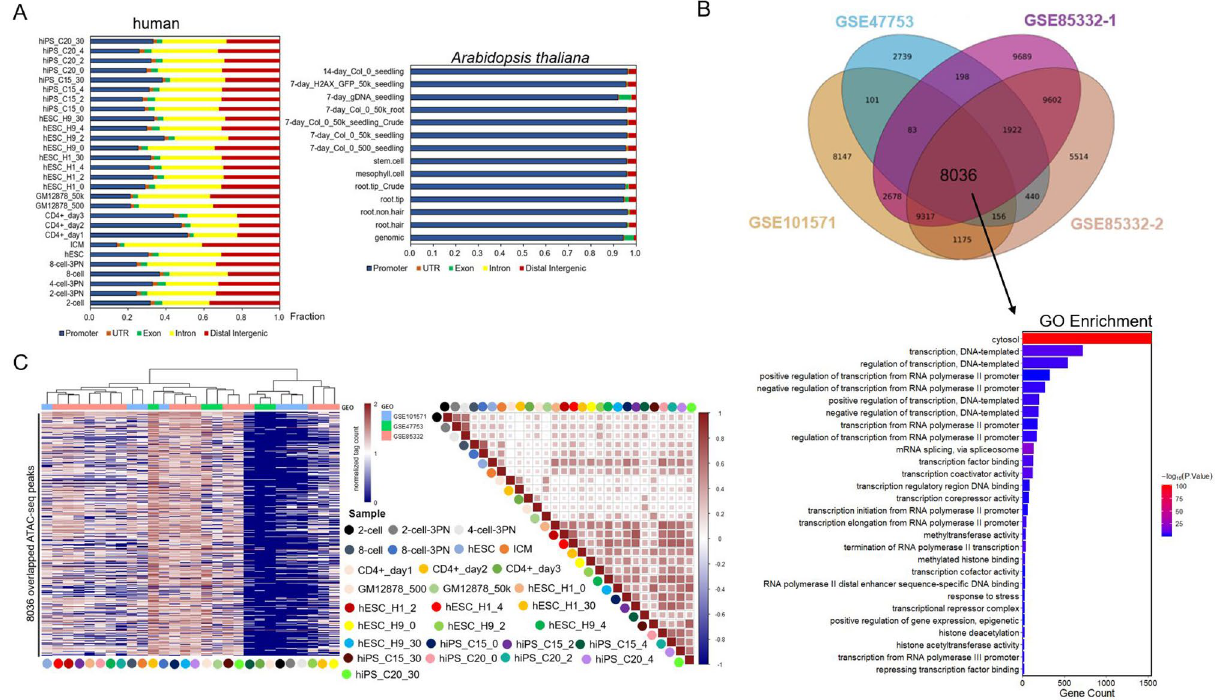
Figure 2. Genomic and functional annotation of accessible regions. ( A ) Genomic distributions of enriched accessible regions identified in ATAC-seq samples. THS peaks within TSS ± 3 kb are considered as promoter THS, and those not located in promoters, exons, introns, or UTRs are labeled as distal intergenic. ( B ) GO functional enrichment analysis of overlapped peaks. Upper part integrates Upset and Venn method to identify overlapping peaks across all human samples. Bottom part is a bar plot of GO enrichment of overlapping peaks. ( C ) Heatmaps showing the ATAC-seq enrichment (RPKM) (left) and the comparison of ATAC-seq signal within consensus ATAC-seq peaks by Pearson’s Coefficient Correlation algorithm. The colored bubbles represent different samples. The ATAC-seq enrichment signals were normalized by log2(FPKM +